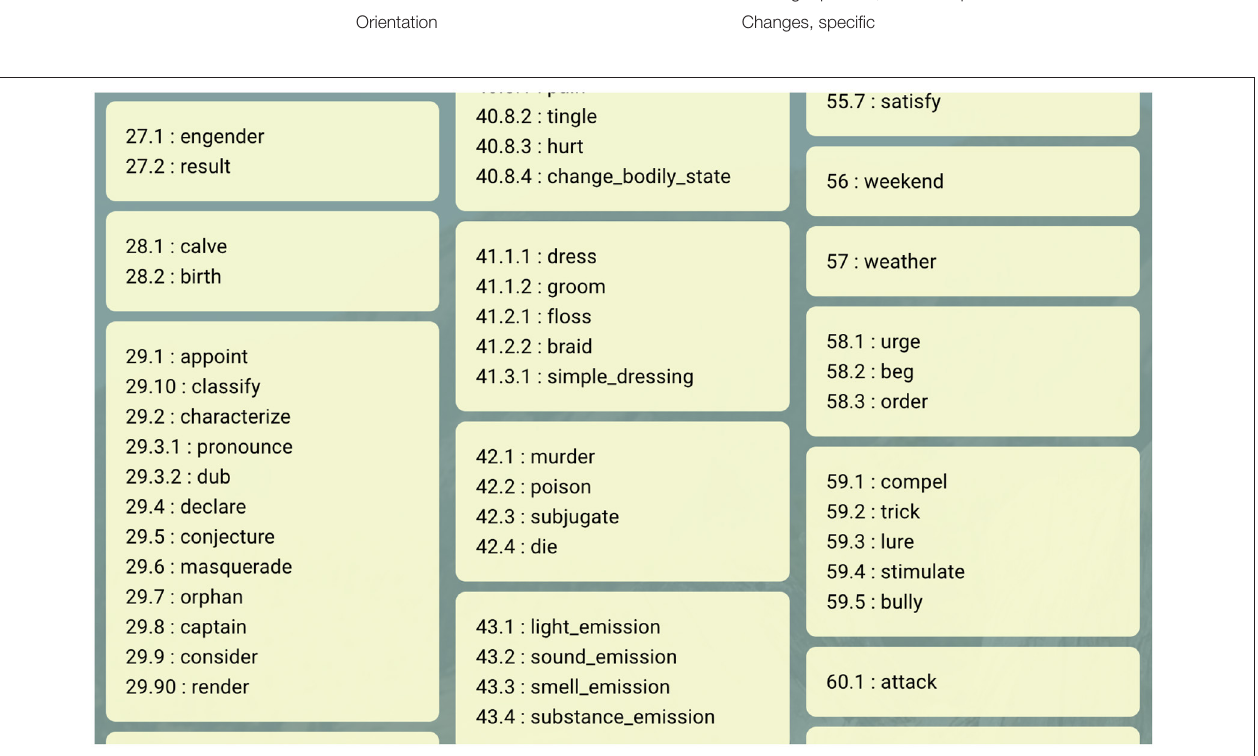
FIGURE 1 | A screenshot of a subset of the VN class hierarchy, from the